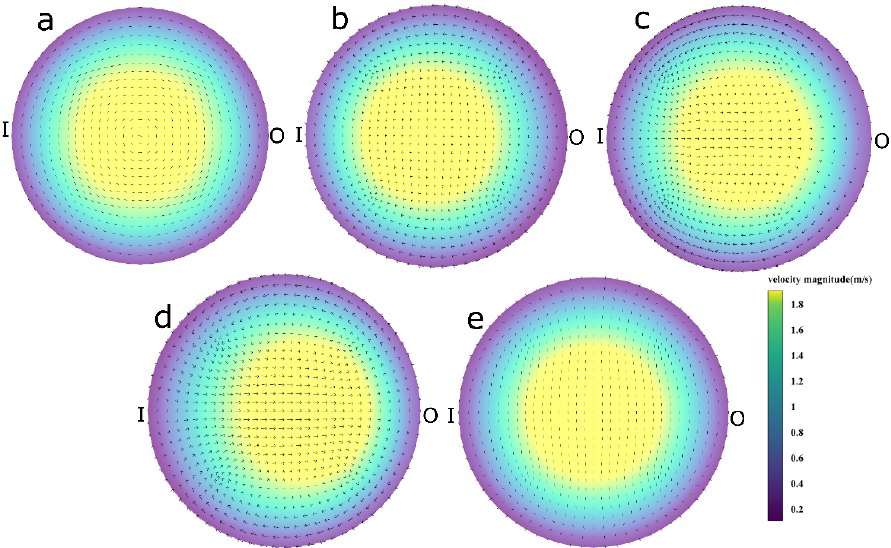
Figure 4. In the 90° channel at the conveying rate of 2.85 cm 3 /s, the profiles of the velocity magnitude and the velocity vectors on the five slices as indicated in Figure 2a. The slices ( a – e ) are from the inlet to the outlet. I represents the inner wall side, while O represents the outer wall side.